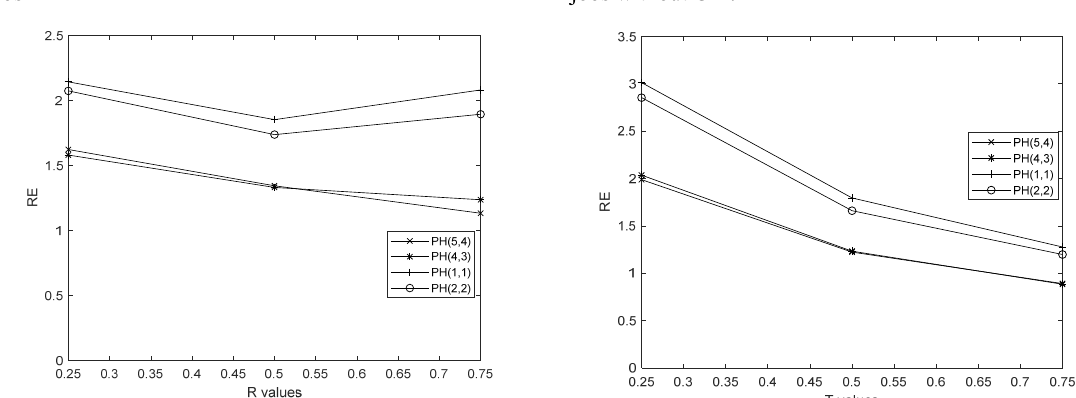
Fig. 8. Heuristic comparisions with respect to R values Fig. 9. Heuristic comparisions with respect to T